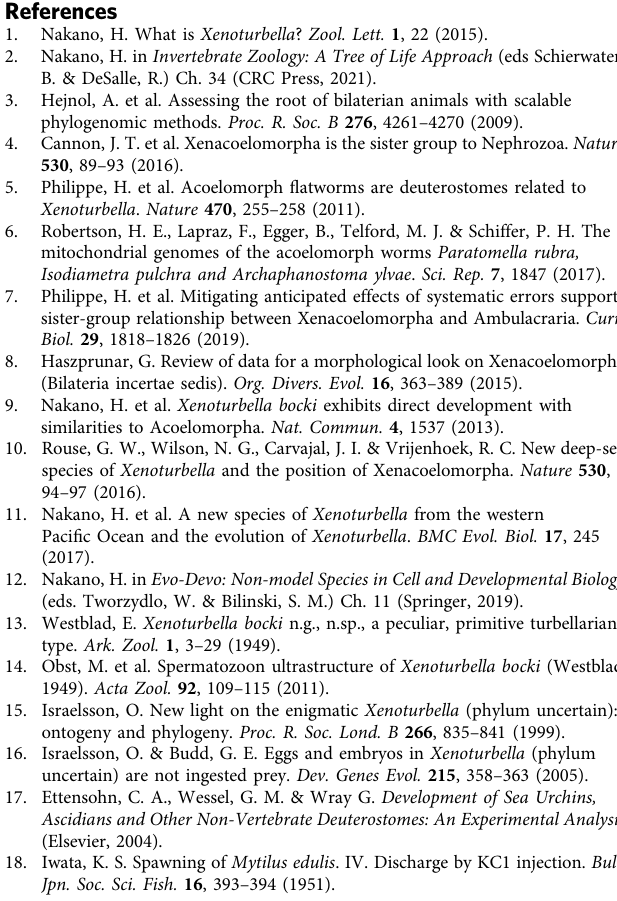
Fig. 7 Gametogenesis of Xenoturbella . Schematic drawing showing a transverse section of Xenoturbella . a Germ cells are present on the surface of the gut. b Gametes sink into pockets within the gut as they mature. Mature gametes are present in the gut cavity ( c ) or between the epidermis and the gut ( d ). e Tunnel connecting the two spaces are present in